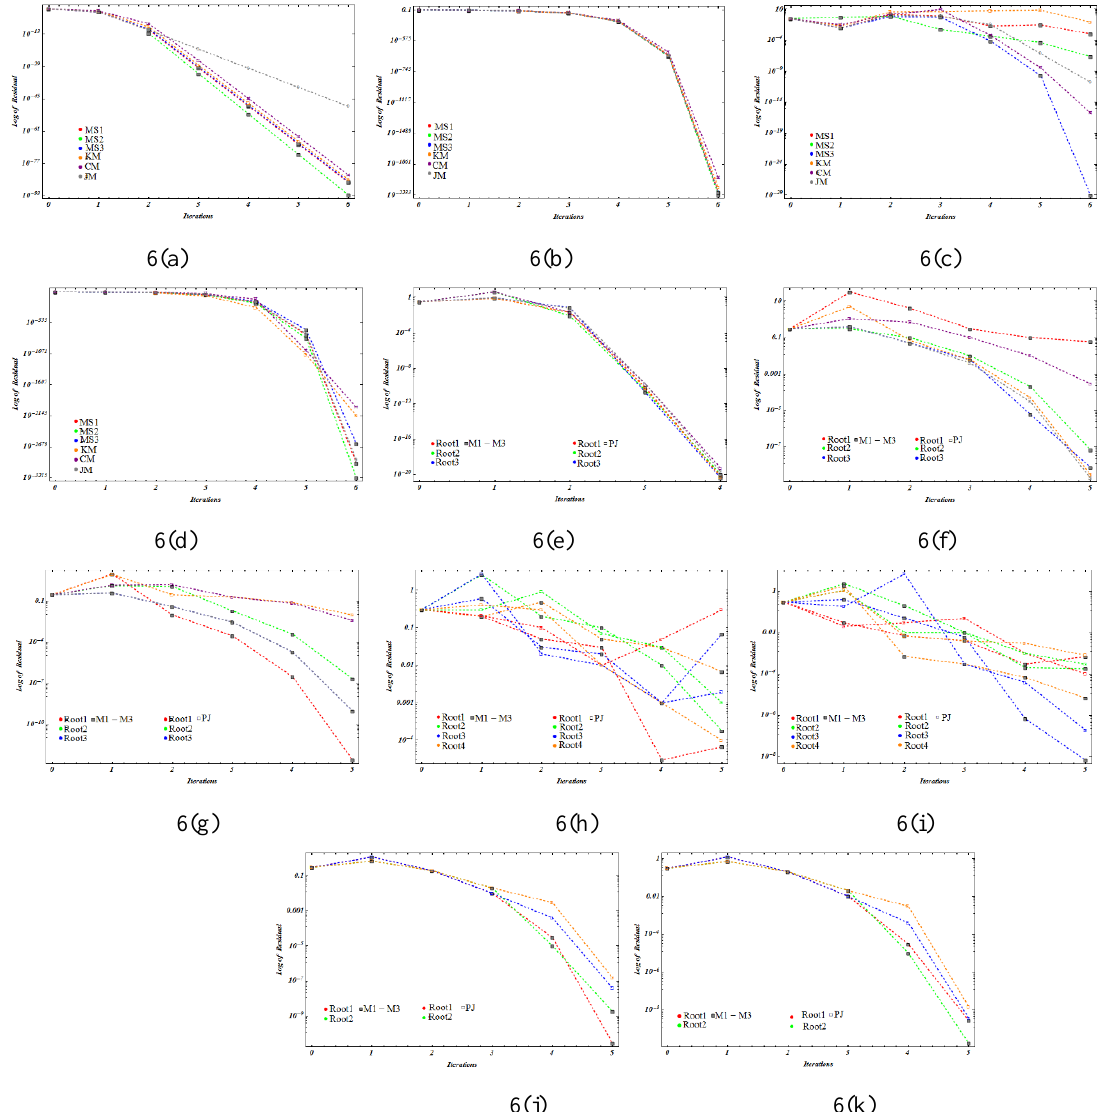
Fig. 6. (a-d), shows residual fall of iterative methods MS1-MS3, KM, CM, JM, (e, g, i, k) presents the residual fall of simultaneous iterative methods (MM1-MM3,PJ6) for finding all distinct roots while, (f, h, j) are for all multiple roots of non-linear function f_5(s), f_6 (s), f_7(s) and f_8(s)